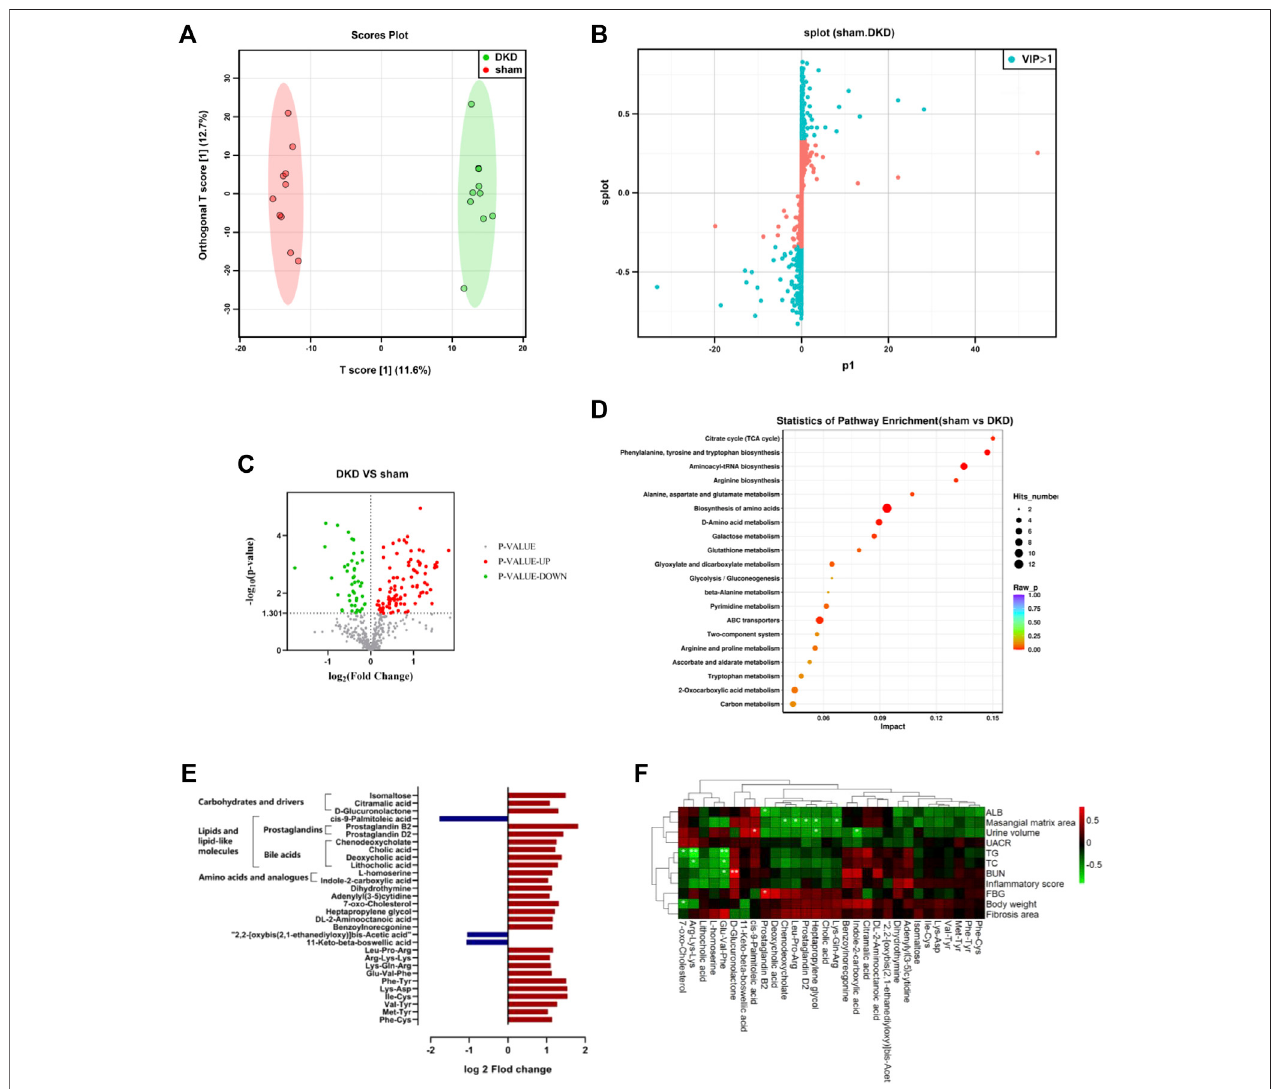
FIGURE 2 | Signi fi cantly altered circulating metabolic pro fi le in the DKD group. (A) OPLS-DA plots with scores of the fi rst two principal components. (B) S-plots of the OPLS-DA model from sham and DKD rats. (C) Volcano plot of the different metabolites obtained according to the screening criteria from sham and DKD rats. (D) Bubble plot of the KEGG pathway enrichment analysis of 315 markedly different metabolites. (E) Further screening from differential serum metabolites according to the following condition: log2 fold change > 1 or < − 1. (F) Correlation analysis between base parameters related to DKD, semi-quanti fi cation of renal damage, and 30 differential serum metabolites using Spearman ’ s rank correlation (* p < 0.05, ** p < 0.01).